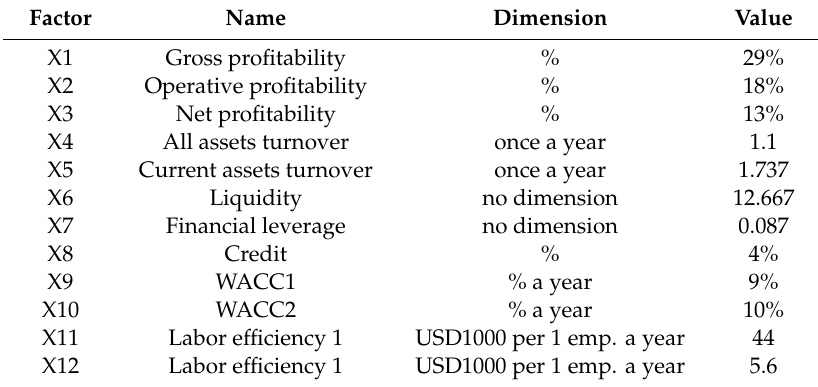
Table 2. ABS statistics of